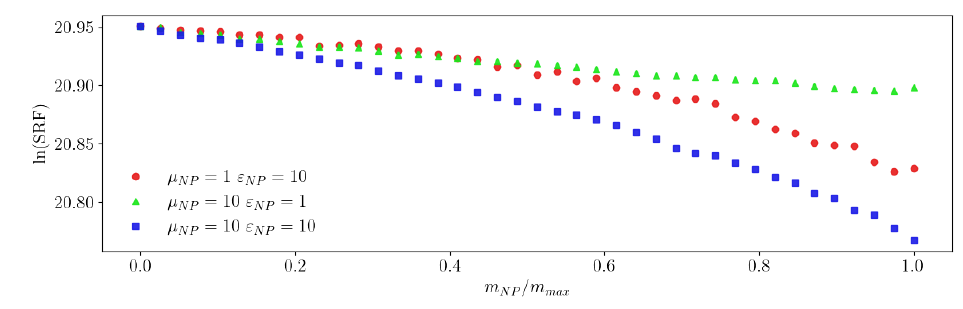
Figure 7. Dependence of the ln ( SRF ) on the ratio m NP / m max for the simulated NPs.